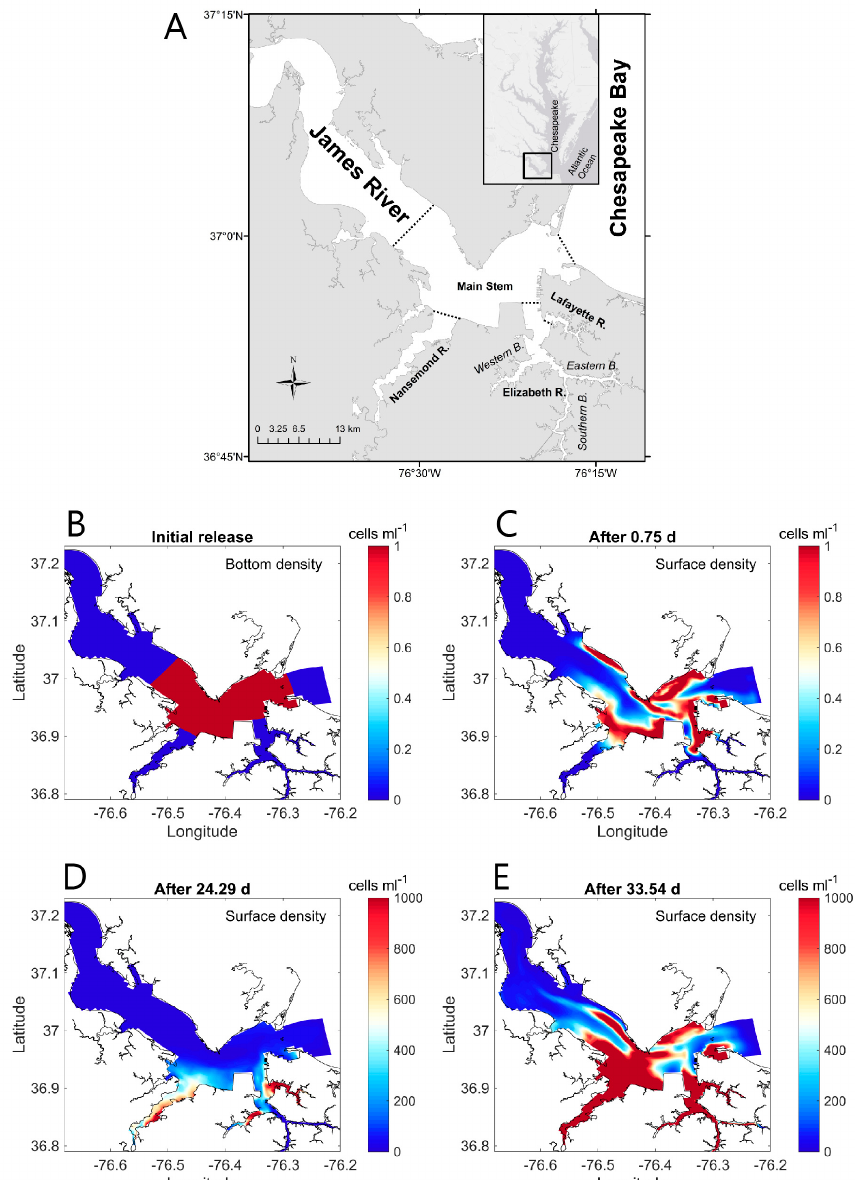
Figure 21. ( A ) Map of the lower James River (USA) and its tributaries [199]. From a 3D model simulation performed by Qin and Shen [199], algal cell densities ( B ) specified as the initial condition (non-zero cell densities initially only in the bottom layer of the lower James River mainstem), and computed cell densities ( C ) after 0.75 d; ( D ) after 24.29 d, when average surface density of the entire Lafayette River first reached bloom levels (1000 cells / mL); and ( E ) after 33.54 d, when the average surface density of the mainstem first reached bloom levels. These results are consistent with observations and with a simple theoretical model indicating that a simple parameter—the ratio of subregion residence time to its volume—can predict where harmful algal blooms are first observed [199]. (Modified from Qin and Shen [199], with permission from